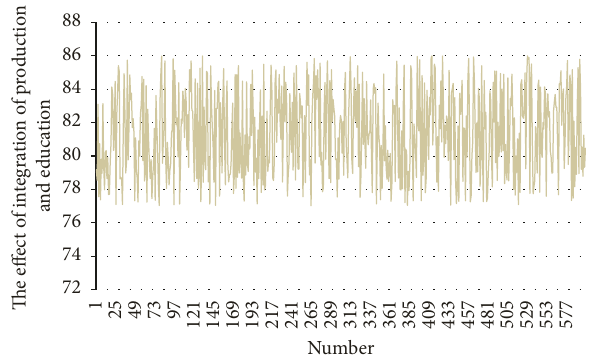
Figure 9: The training effect of intelligent transportation tech- nology